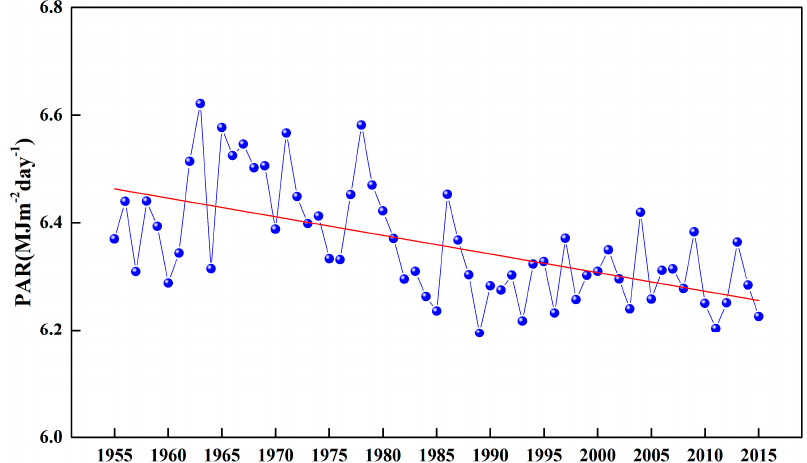
Figure 10. Annual mean PAR over China, during 1955–2015 (red line is the trend line). Remote Sens. 2018 , 10 , x FOR PEER REVIEW